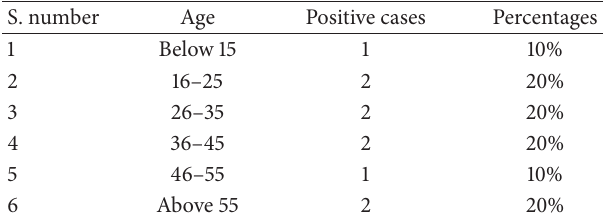
Table 2: Agewise distribution of patients positive for leptospiral antibodies.